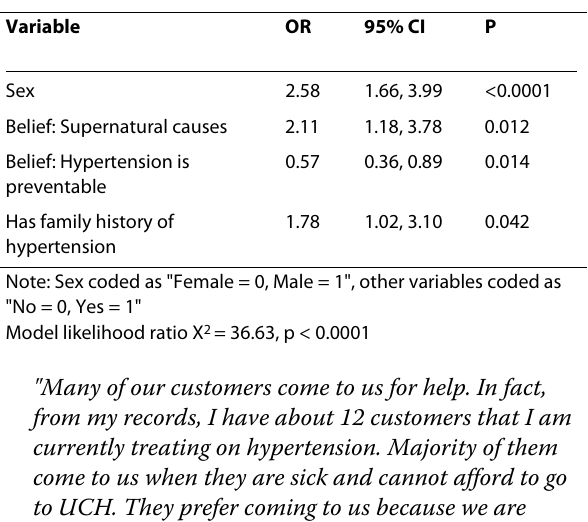
Table 5: Logistic regression analysis to identify independent predictors of CAM